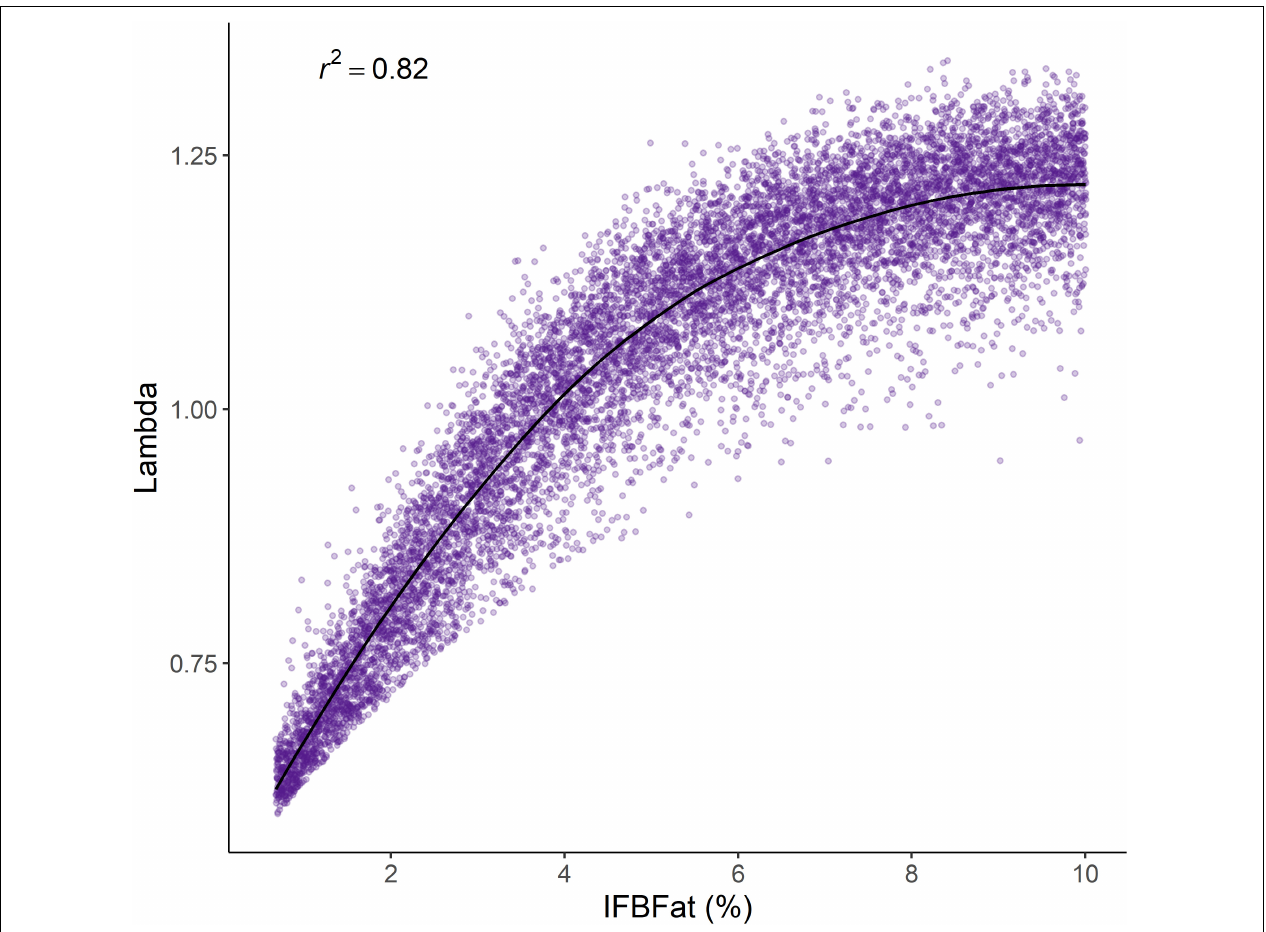
FIGURE 4 | The variation in λ (fitted with smoothing loess) explained by the cumulative effects of percent IFBFat on pregnancy, parturition, and overwinter survival of adult ( > 2.5 years) female moose in Sublette 2012–2014, western Wyoming, United States.